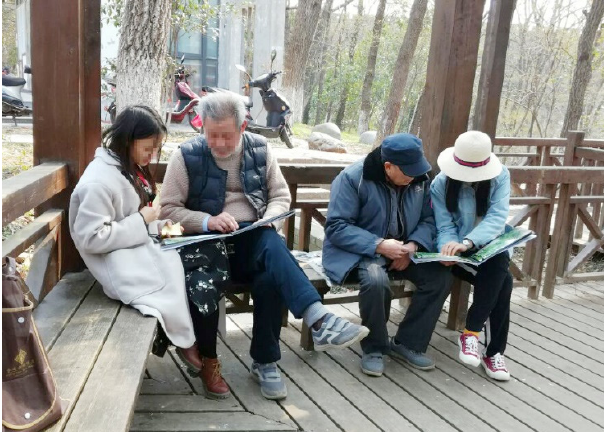
Figure 11. Participants did surveys in a pavilion along the walkway, together with the research assistants (faces were modified with a mosaic to protect privacy).